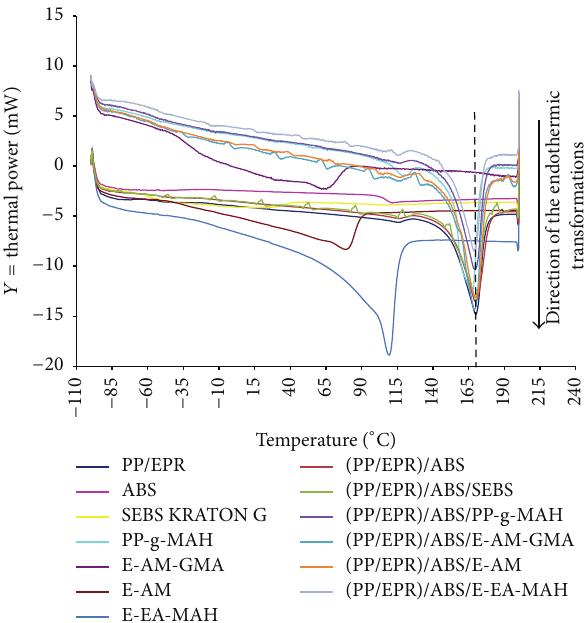
Figure 6: DSC curves in the direction of the endothermic trans- formations of components and mixtures (PP/EPR)/ABS/compati- bilizer (93.5)/5/1.5, for the second thermal cycle. For about 15mg of sample. 1 graduation 𝑌 = 5